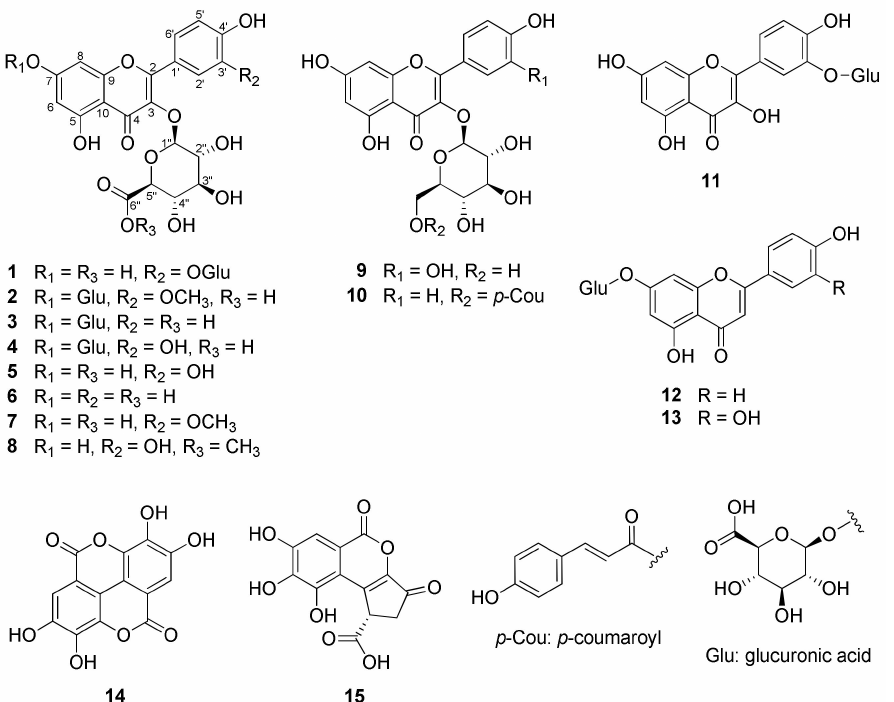
Figure 1. Structures of compounds 1 – 15 isolated from the leaves of P. chinensis .